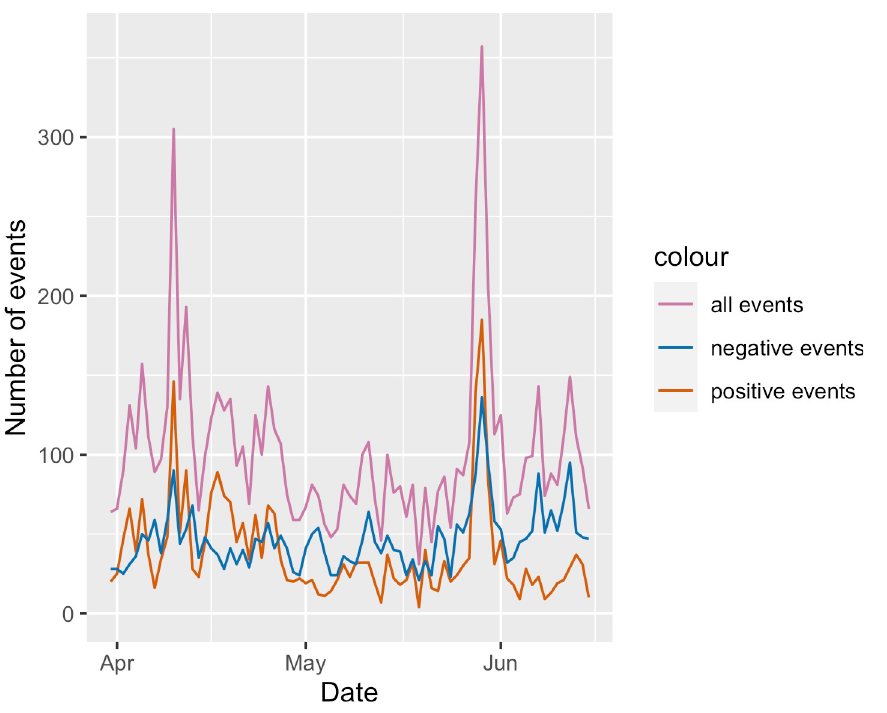
Fig 5. Raw event count time series for source and target filtered data.